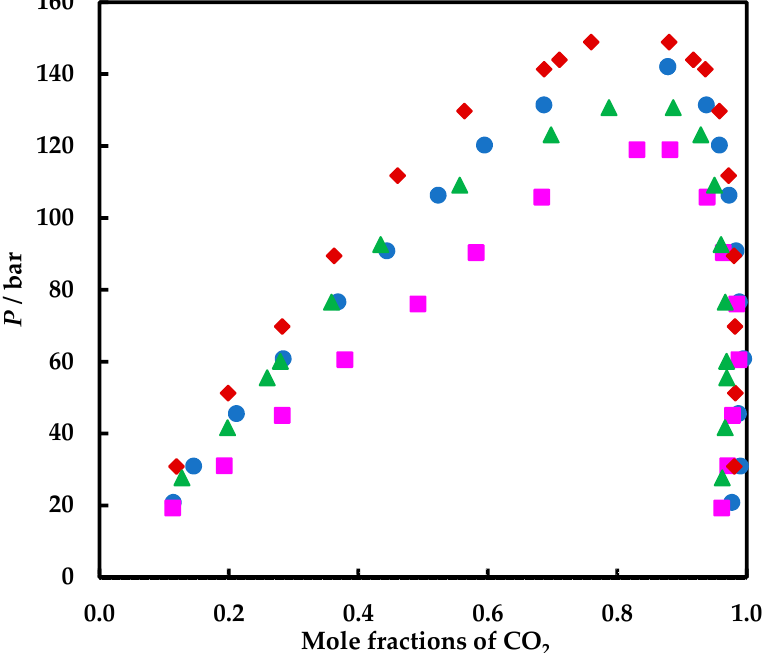
Figure 2. Comparison of measured and literature data for carbon dioxide (1) + 1-butanol (2), + 2-butanol (2), + isobutanol (2), and + tert -butanol (2) binary systems at 365.15 K. CO 2 + 1-butanol: (cid:7) , [47]; CO (cid:78) [47]; CO (cid:4) , this • this work; CO 2 + 2-butanol: 2 + isobutanol: 2 + tert -butanol: